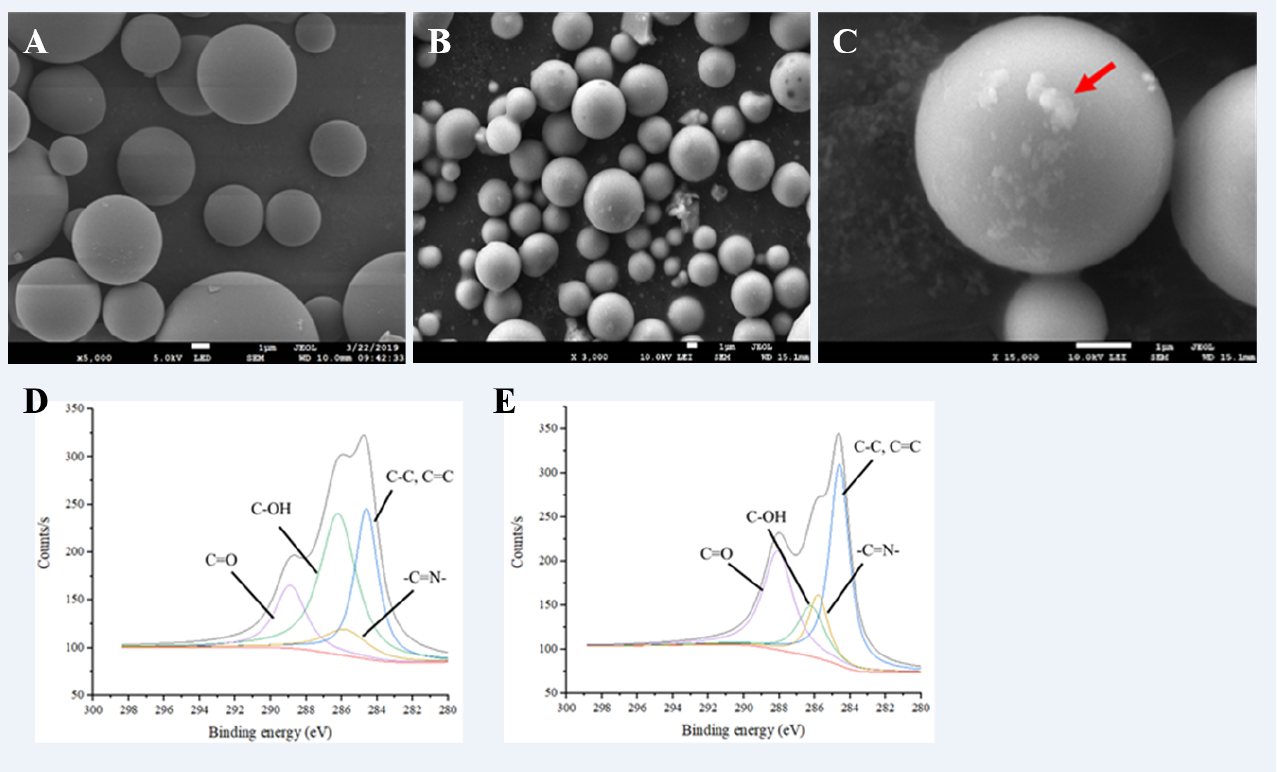
Figure 1. SEM images and the C element scan of glass microspheres without and with β‐ glucosidase immobilization. The SEM images of glass microspheres without β‐ glucosidase immobilization at 5000× magnification power ( A ), and with β‐ glucosidase immobilization at 3000× ( B ) and 15,000× ( C ) magnification power. The C element scan without ( D ) and with ( E ) β‐ glucosidase immobilization by ESCA. The characteristic signals at 284.6, 285.8, 286.2 and 288.9 eV corresponded to C ‐ C, C=N, C ‐ OH and C=O, respectively. The red arrow is pointing the attached β‐ glucosidase.